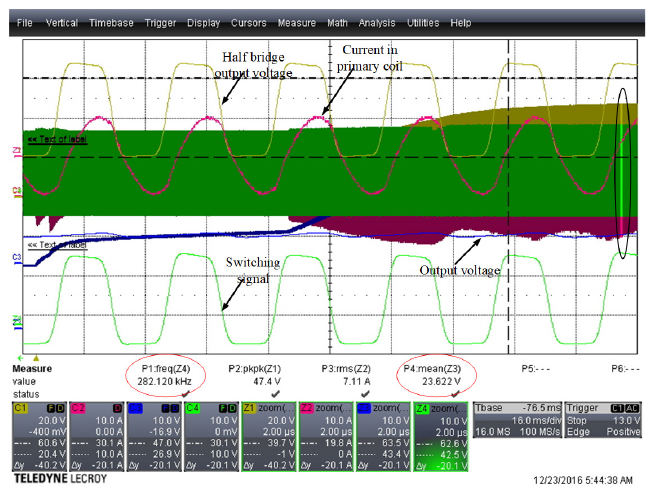
Figure 24. Waveform of controlling output 23 V.